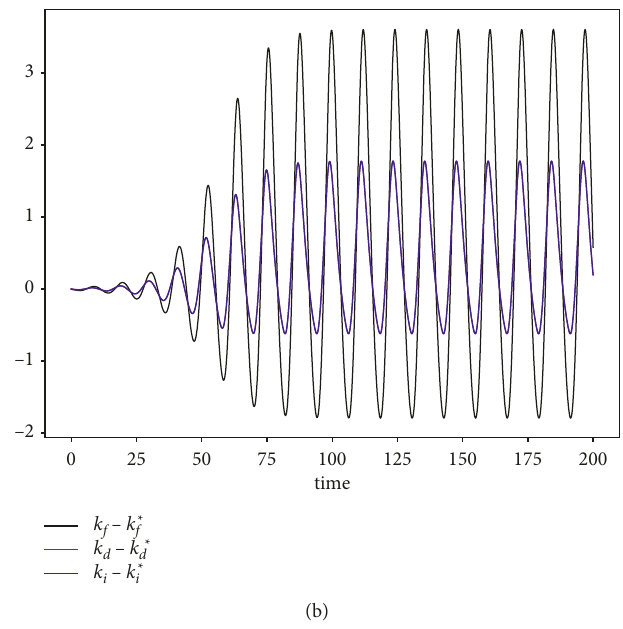
Figure 3: Lead and lag plots. (a) ( y